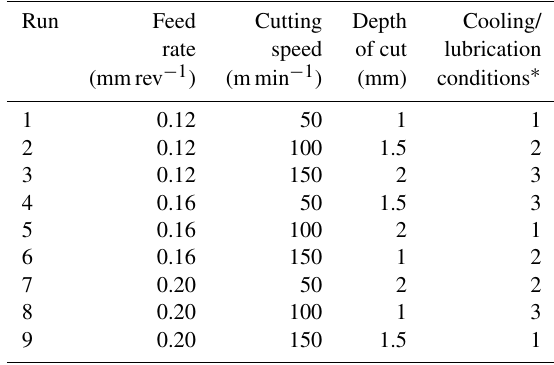
Table 4. Taguchi Orthogonal Array (L9) of cutting